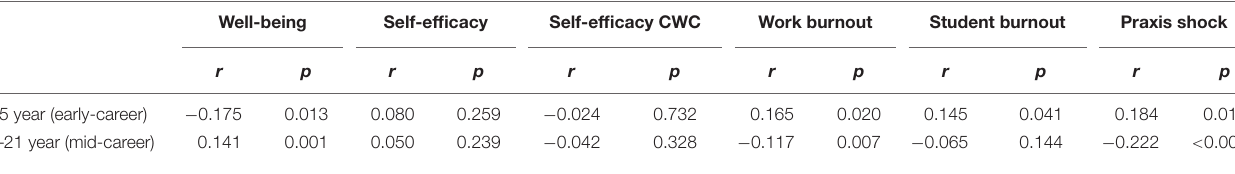
FIGURE 1 | Self-efficacy, well-being, work burnout, praxis shock, and student burnout as a function of years teaching, all with linear fits to the data. TABLE 5 | Bivariate relationships between number of years teaching and all outcomes for early-career, mid-career, and late-career periods in the profession. Well-being Self-efficacy Self-efficacy CWC Work burnout Student burnout Praxis